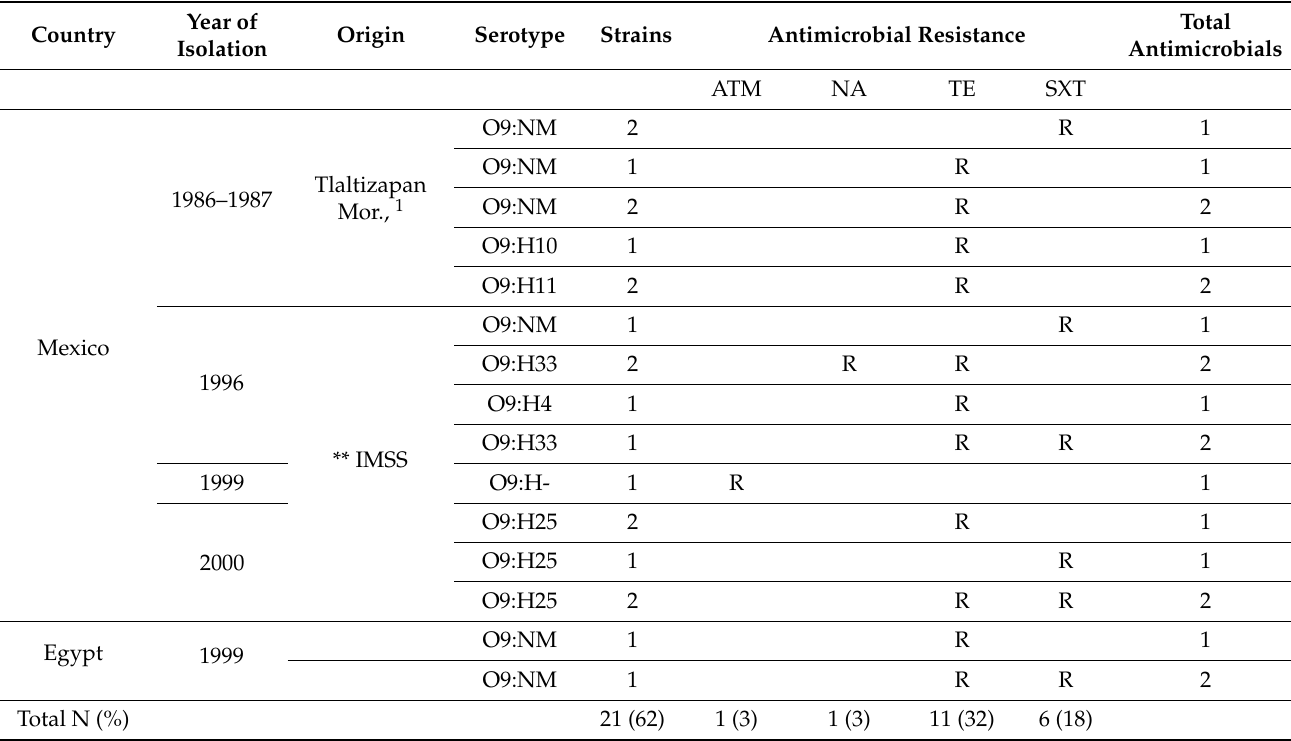
Table 6. Resistance patters of E . coli O9